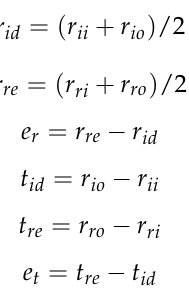
Figure 7. The stress nephogram of the CRFF part: ( a ) Total model; ( b ) Final tube net.